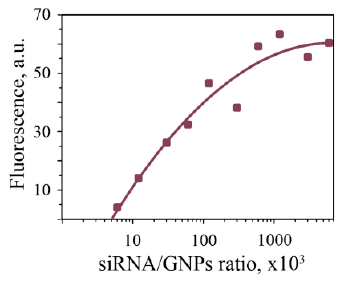
Figure 3. Relative fluorescence intensity of gold nanoparticles-siRNA (GNPs-siRNA) complexes, stained with acridine orange.